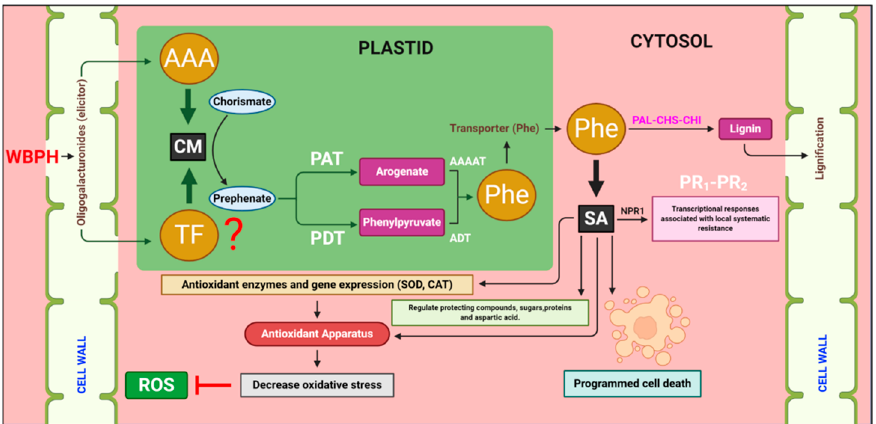
Figure 7. Proposed model of the molecular mechanisms of white-backed planthopper (WBPH) resistance in rice plants. WBPH infection stimulates the expression of chorismate mutase ( CM ) gene, which converts chorismate into prephenate. Prephenate is either converted into arogenate by prephenate aminotransferase ( PAT ) or to phenylpyruvate by prephenate dehydratase ( PDT ). Both arogenate and phenylpyruvate are catalyzed by aromatic amino acid amino transferase and arogenate dehydratase ( ADT ), respectively, to produce phenylalanine (Phe). This entire process occurs in the plastid. Phe is transported into the cytosol through the Phe transporter and is converted to lignin and salicylic acid. The induction of the CM gene regulates downstream lignin synthesizing genes, such as, phenylalanine ammonia lyase ( PAL ), chalcone synthase ( CHS ), and chalcone isomerase ( CHI ), which enhance lignification in the cell wall in response to pathogen infestation. CM gene induction also regulates the SA signaling, which induces catalase (MDA), glutathione peroxidase (GPx), and antioxidant-related genes, such as superoxide dismutase ( SOD ) and catalase ( CAT ), which scavenge reactive oxygen species (ROS) and reduce oxidative stress.